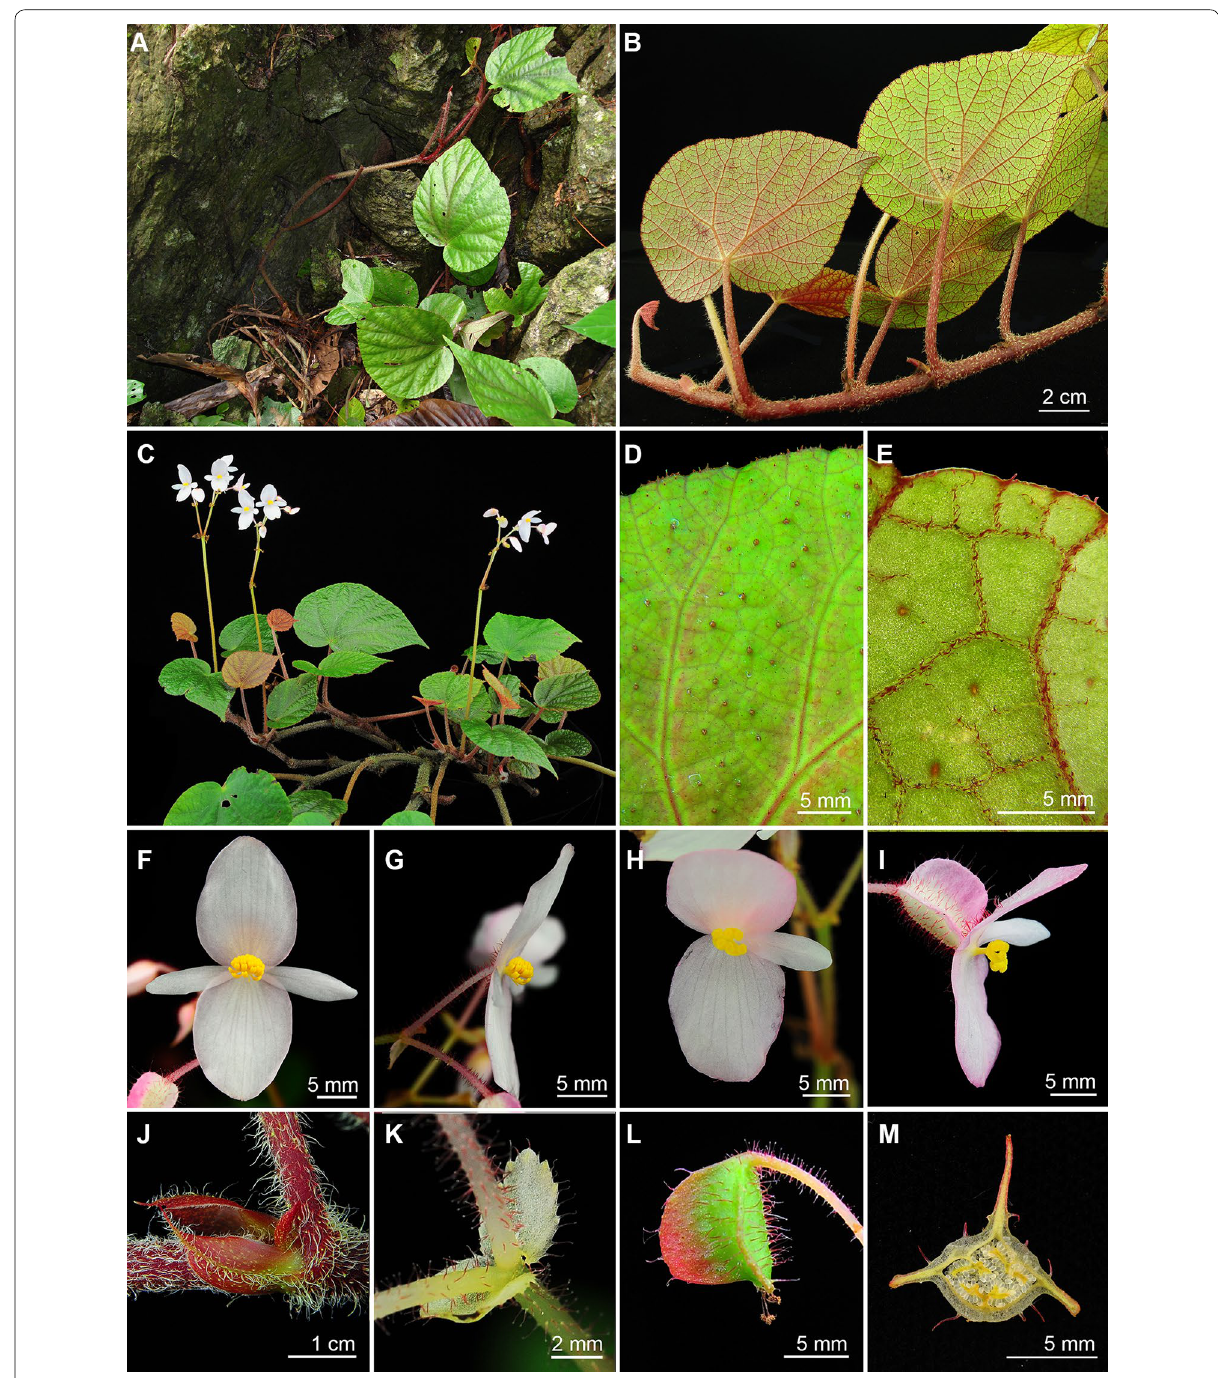
Fig. 8 Begonia longiornithophylla C.I Peng, W.B.Xu & Yan Liu. A Habitat and habit; B Habit, showing rhizome and leaf abaxial surface; C Cultivated plant at anthesis; D Leaf adaxial surface; E Leaf abaxial surface; F , G Staminate flower, face view and side view; H , I Pistillate flower, face view and side view; J Stipules and petiole, showing indumentum; K Bracts, showing glandular hairs on peduncle and pedicels; L Young fruit; M Cross section of ovary. All from Peng et al . 21518